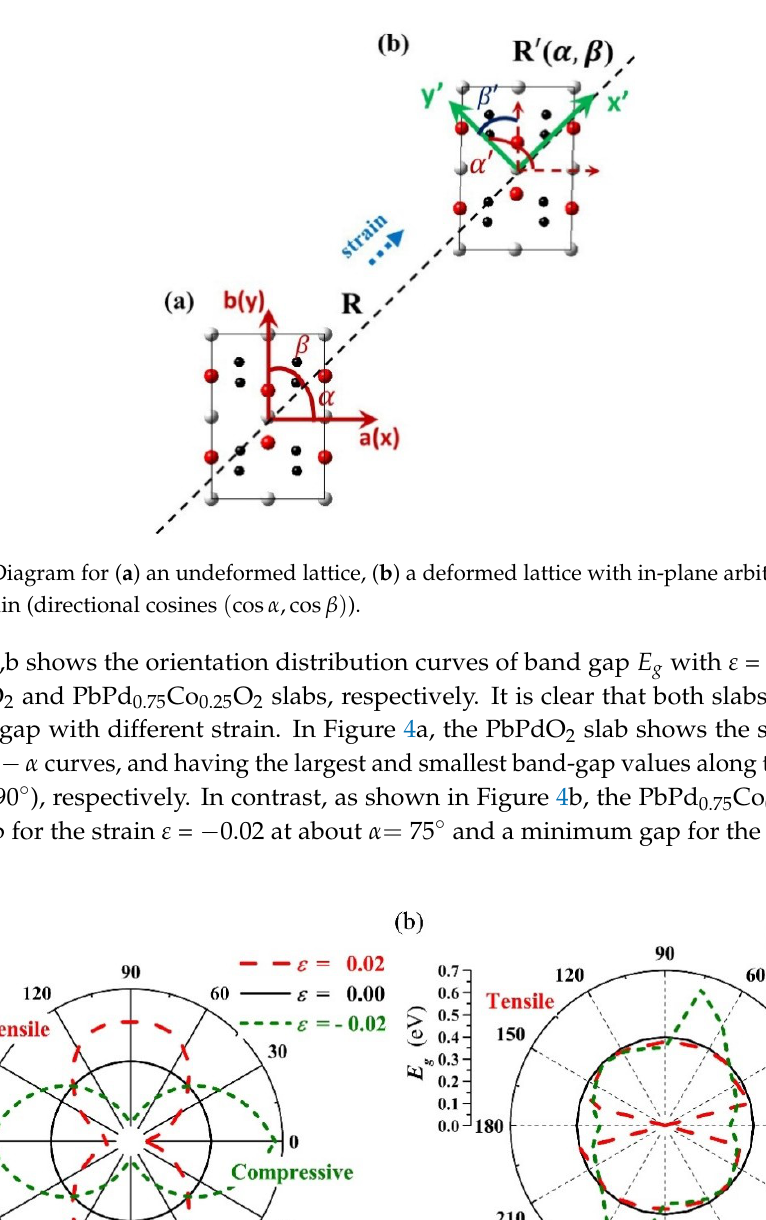
E for ( a ) PbPdO 2 , and ( b ) PbPd 0.75 Co 0.25 O 2 g